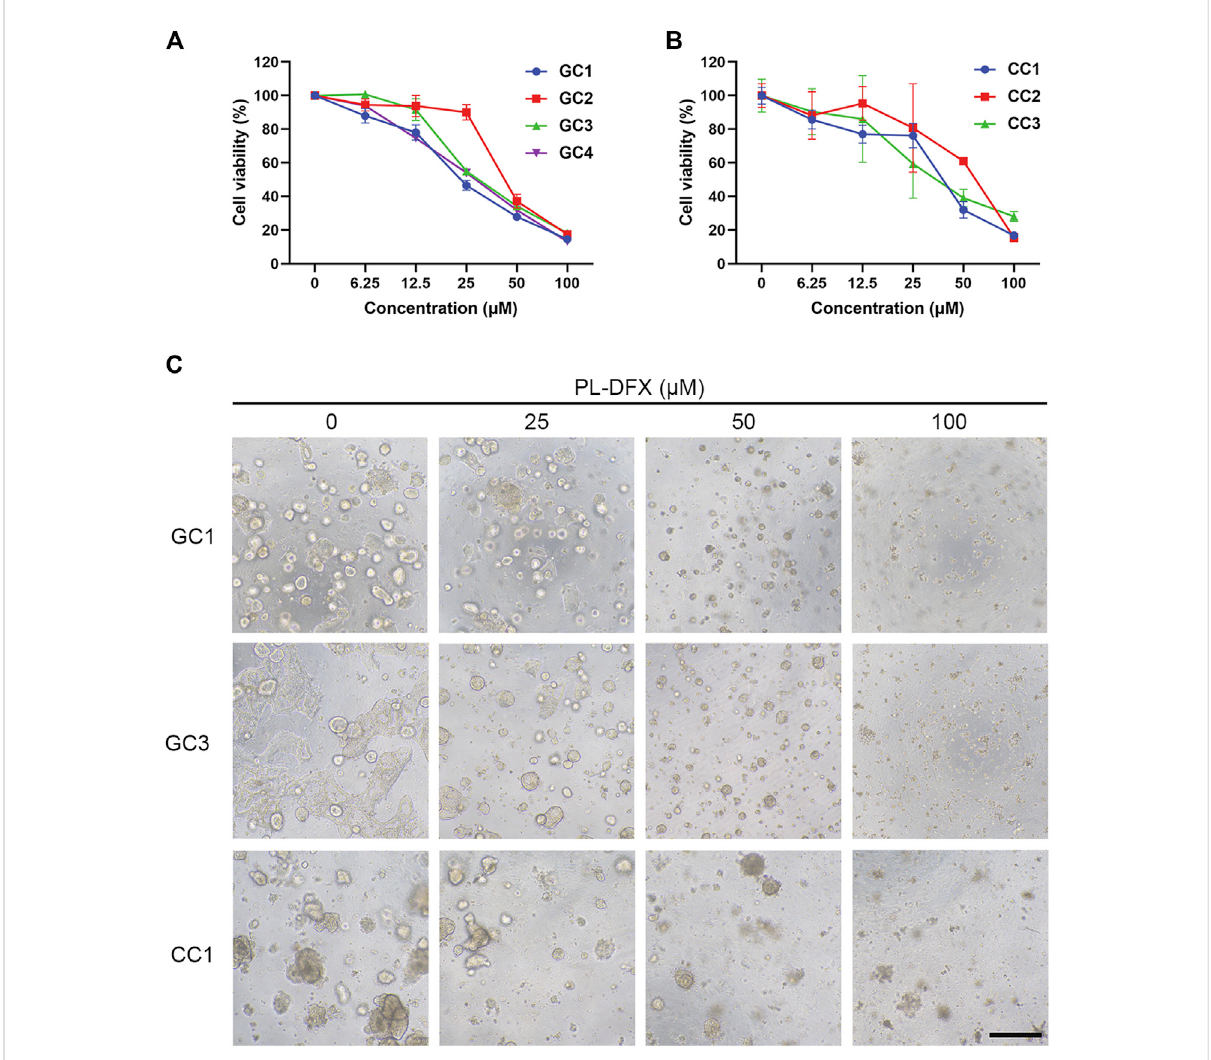
Cytotoxicity of PL-DFX in organoids. (A) Cell viability of gastric cancer organoids after treatment with various concentrations of PL-DFX for 120 h. (B) Cell viability of colorectal cancer organoids after treatment with various concentrations of PL-DFX for 120 h. (C) Microscopic images of gastric and colorectal cancer organoids after treatment with PL-DFX for 120 h. Scale bar: 300 μ m. (GC: gastric cancer organoid; CC: colorectal cancer